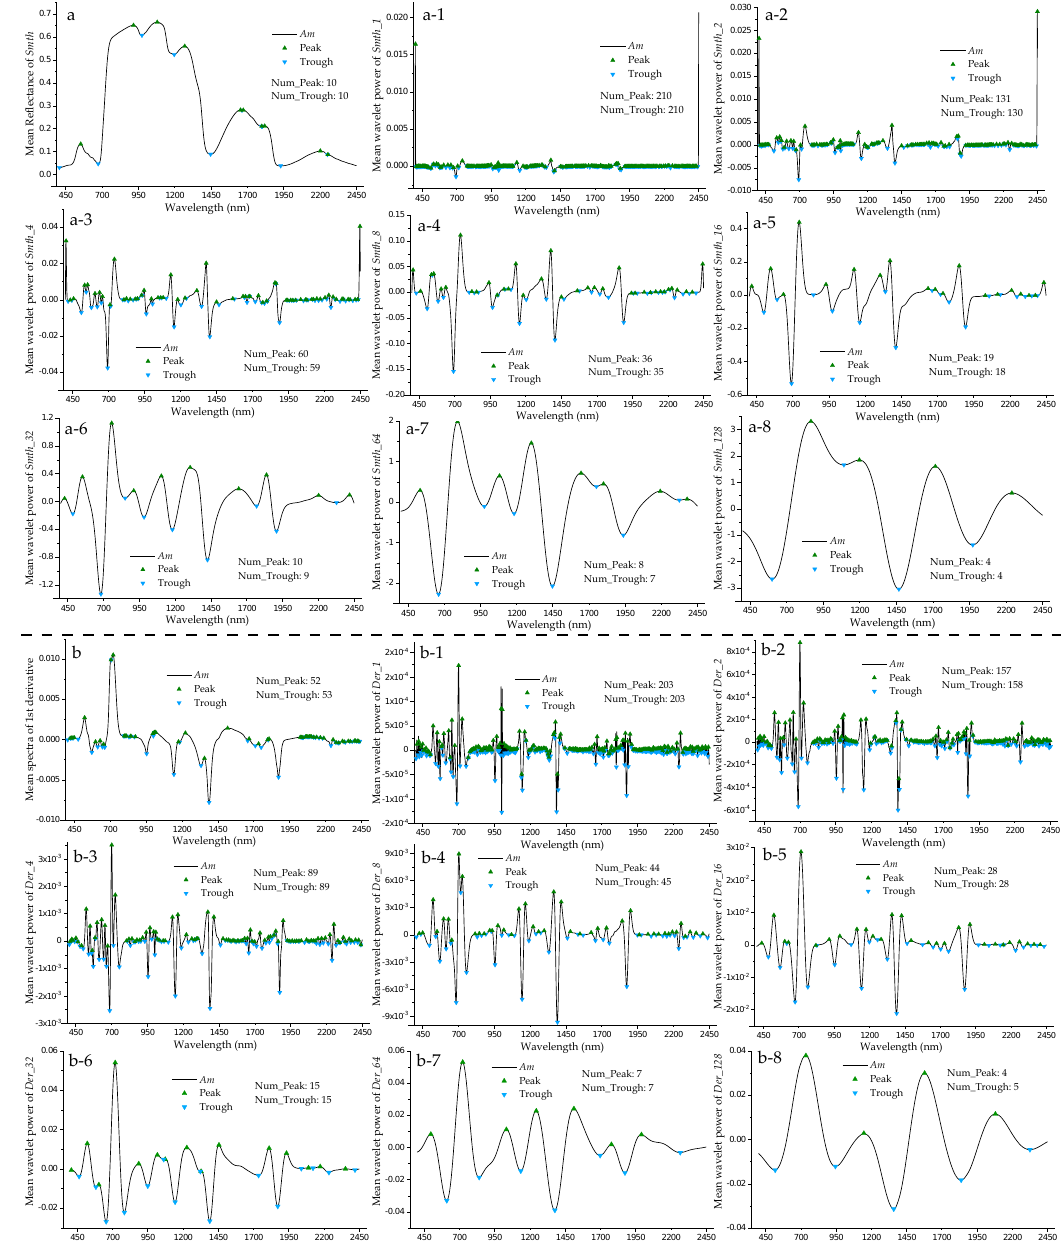
Figure 5. Plots of the mean reflectance ( a ), derivative ( b ), and wavelet power spectra of Smth ( a-1 , a-2 , … a-8 ) and Der ( b-1 , b-2 , … b-8 ) with eight scales (taking Am species for instance). 3 Table 3. The overall accuracies (OAs), allocation disagreements (ADs), and quantity disagreements 4 (QDs) of models with reflectance, derivative, and wavelet power spectra. 5